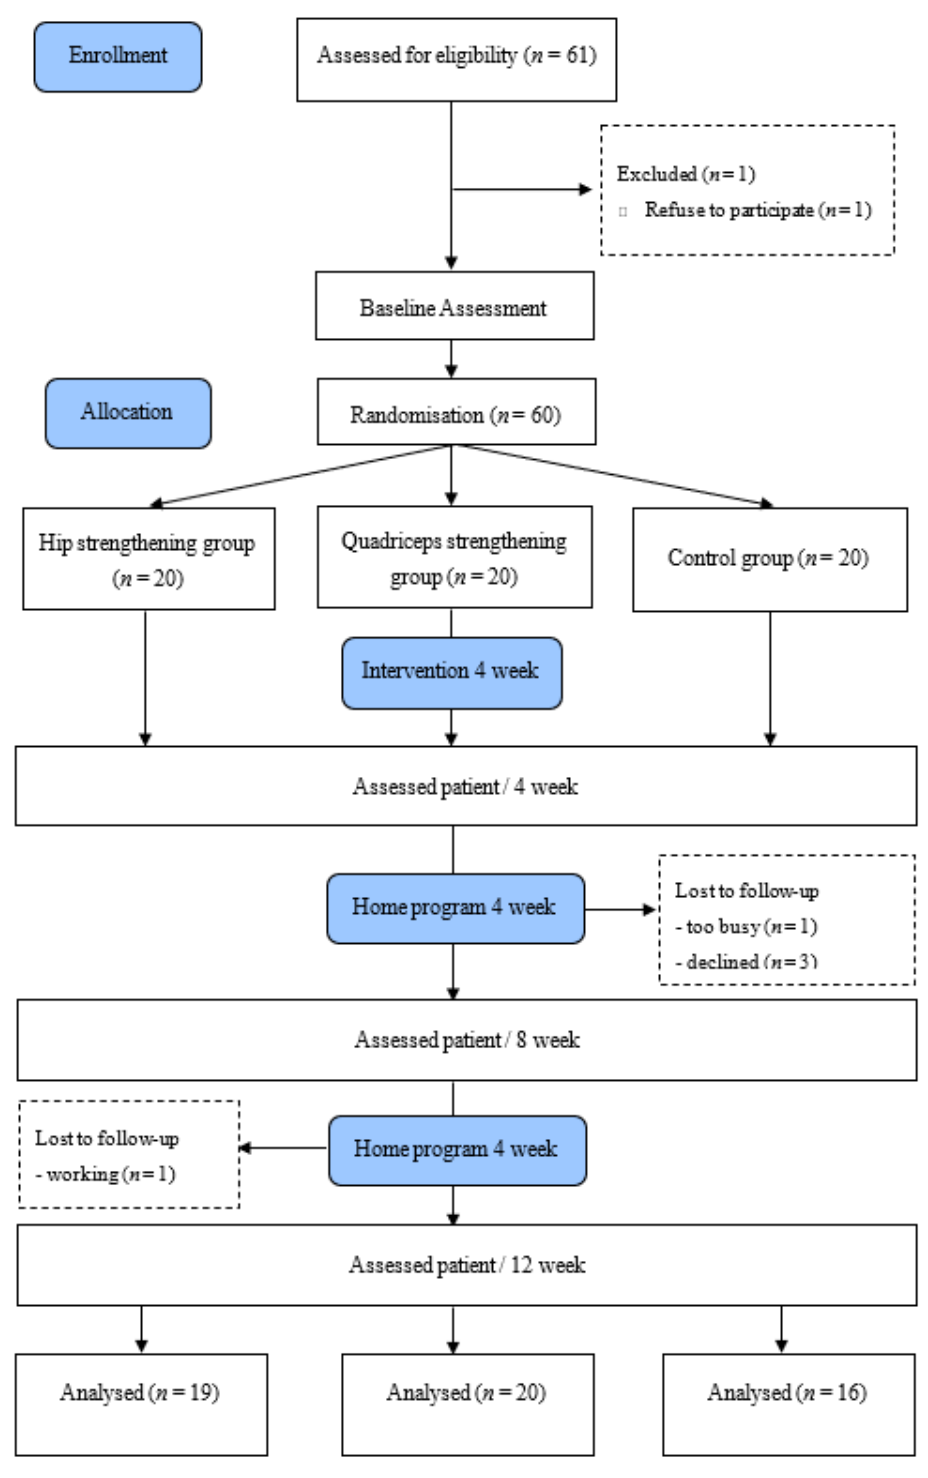
Figure 1. Flow diagram of the experimental procedure.